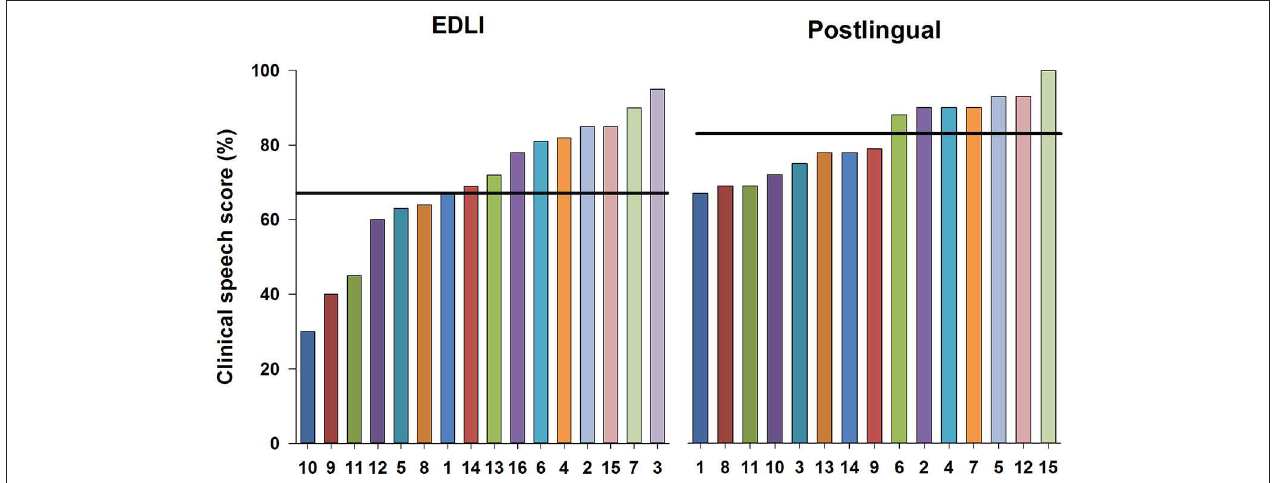
FIGURE 1 | The clinical speech scores shown per individual for the EDLI participant group on the left and for the postlingually deafened control group on the right. The scores are arranged from lowest to highest score in each panel, from left to right. The numbers on the x-axis represent the individuals as numbered in Tables 1 , 2 . The horizontal line represents the mean score per